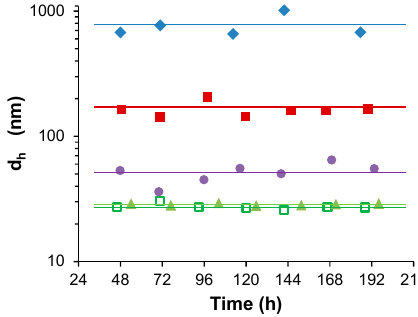
Figure 3. Comparison of stable aqueous colloid dispersions of S-PDMAEMA 60 particles prepared using 10 mM SS/PDMAEMA (1:1) feed ratio. The initial polymer mass concentration is 1.57 g/L. Particle size shows dependence on the pH at the time of the initiation of particle growth. Particle size by mean hydrodynamic diameter is shown for S-PDMAEMA 60 particles prepared at pH 5.9 (red squares ■ ), pH 6.8 (green open squares □ ), pH 6.9 (green triangles ▲ ), pH 7.3 (purple circles ● ) and pH 8.0 (blue diamonds ♦ ).